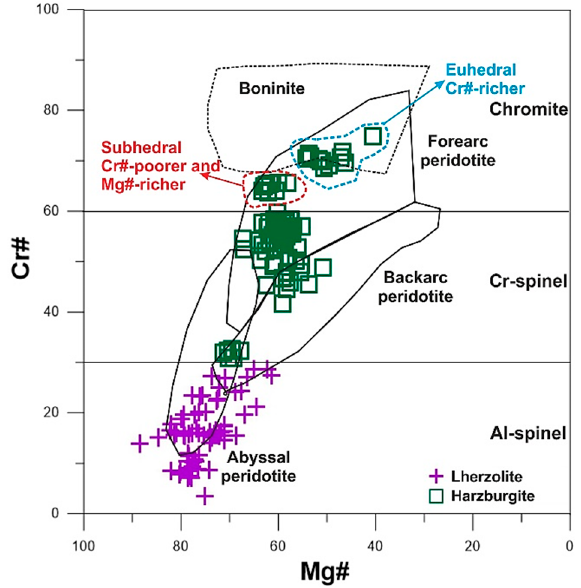
Figure 5. Compositional variations of spinel-group minerals from Edessa peridotites in a Cr# vs. Mg# diagram. Compositional fields for spinel-group minerals in boninite [24,41], forearc peridotite, backarc peridotite, and abyssal peridotite [42] are shown for comparison.